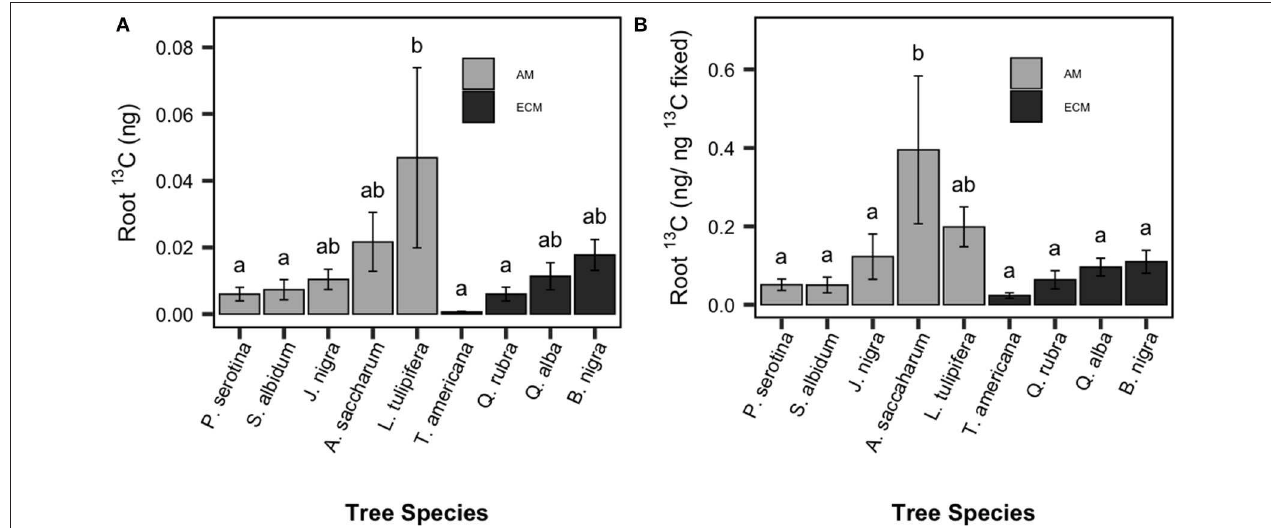
FIGURE 1 | Species patterns in allocation of recently-fixed C allocated to absorptive roots. Total 13 C absorptive root enrichment (A) and relative 13 C absorptive root enrichment per unit 13 C fixed (B) shown. Species means are show with standard error bars. Light bars indicate AM-associated tree species, dark bars indicated ECM-associated species. Letters indicate significant pairwise differences ( P <